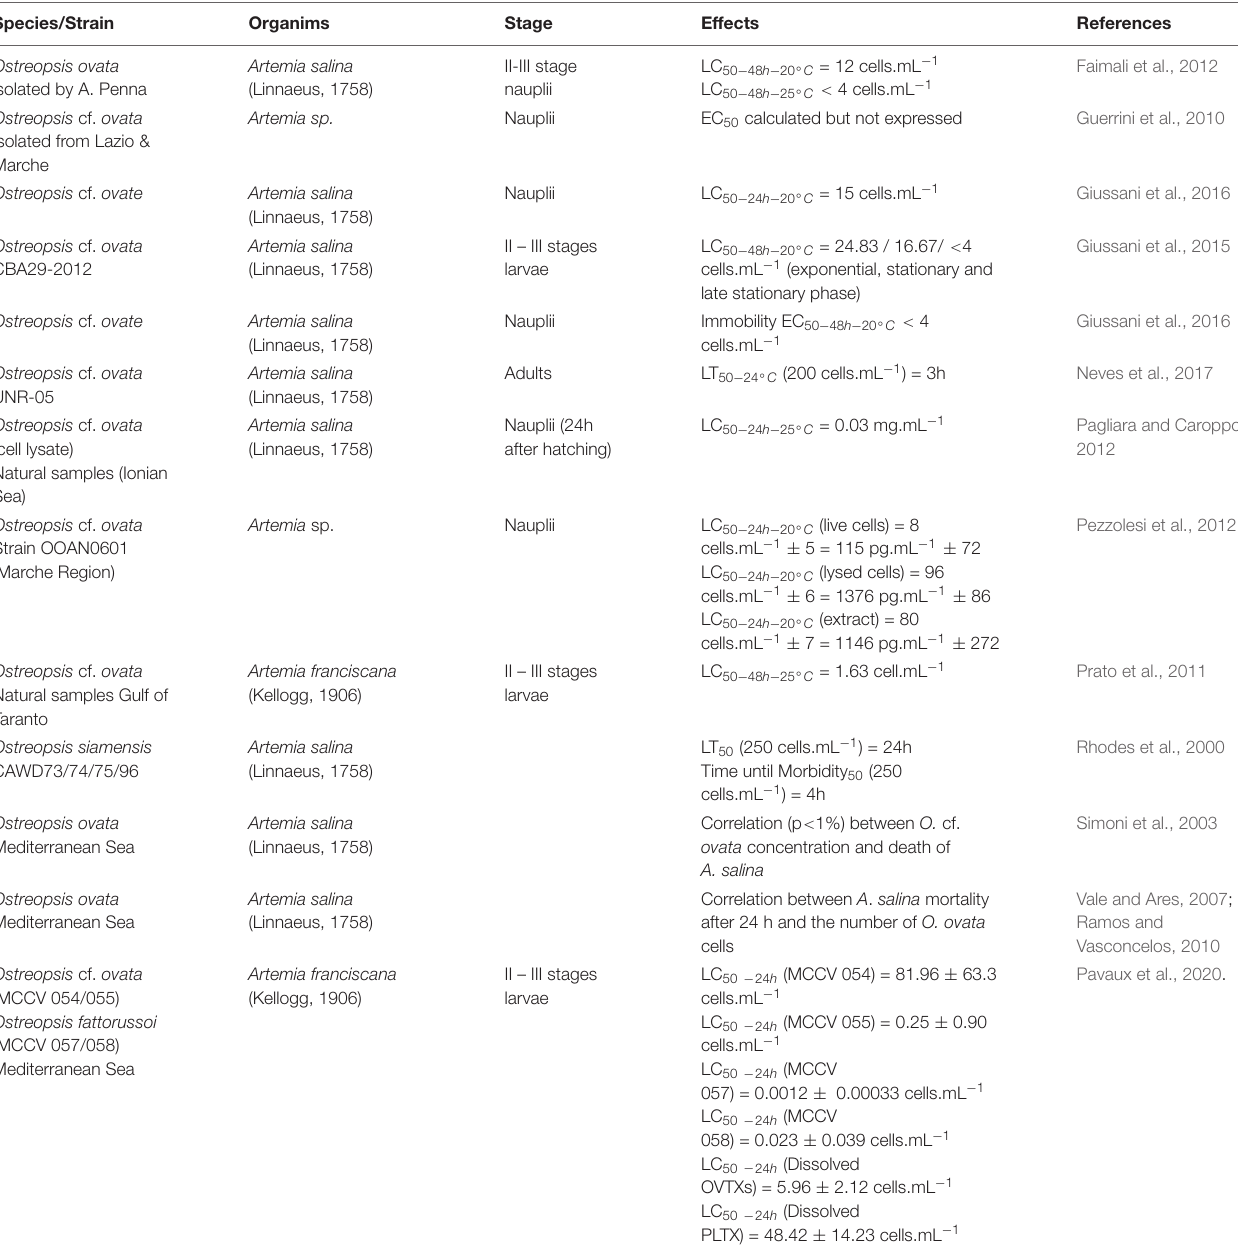
TABLE 5 | Artemia bio-assay for Ostreopsis species